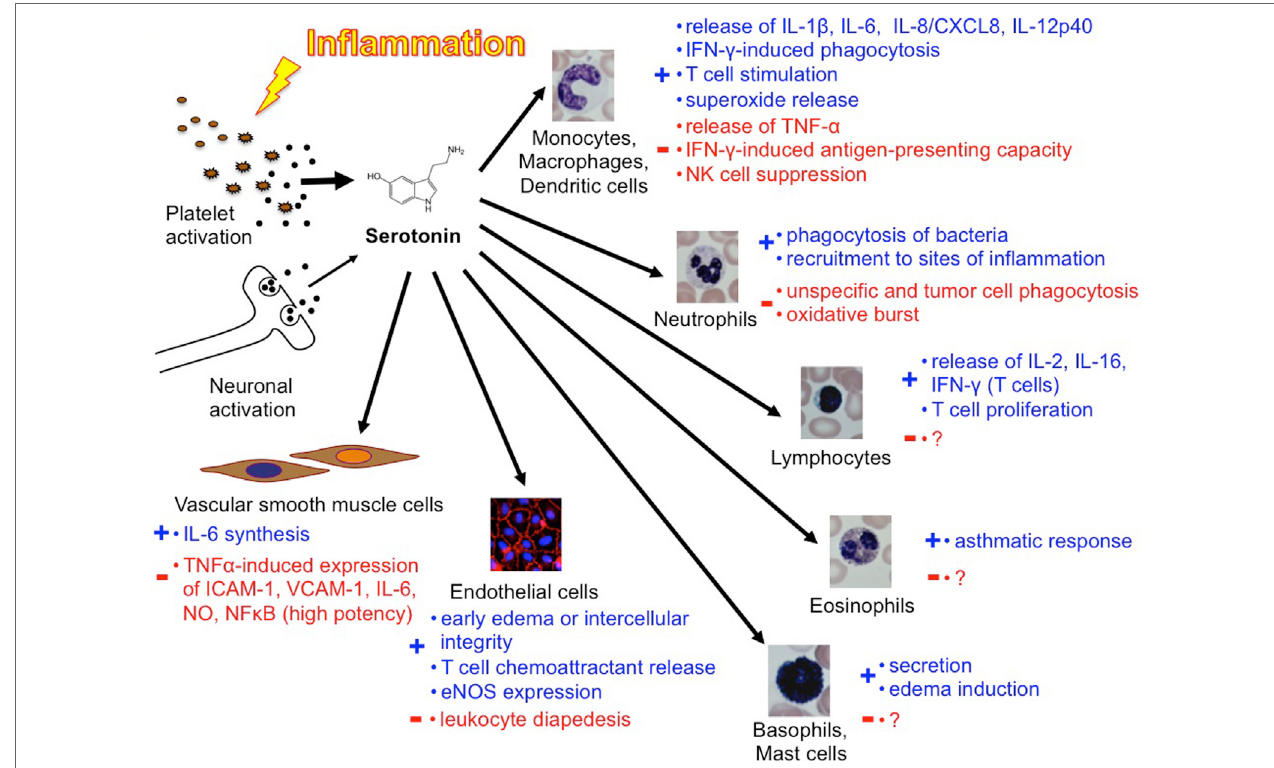
FigURe 3 | Overview of the complexity of the function of platelets and serotonin in inflammation and immunity [Duerschmied et al.